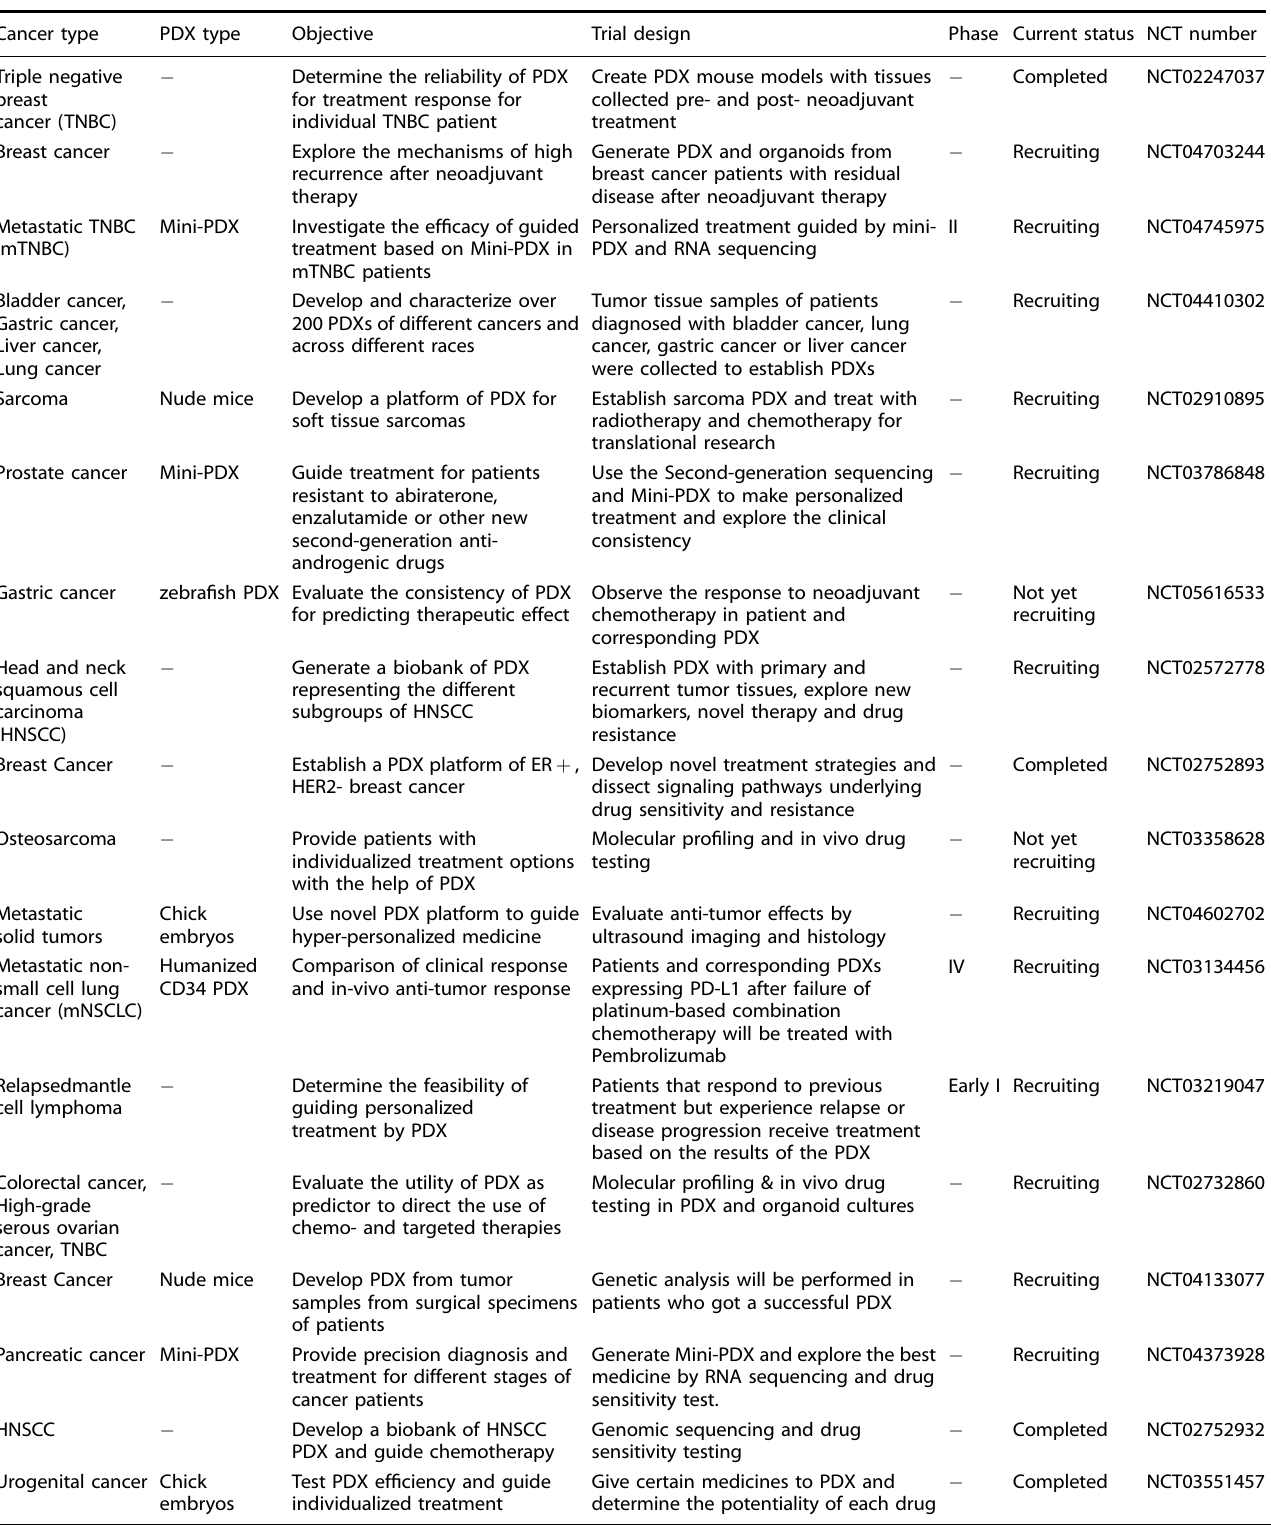
Table 2. PDX related clinical trials Cancer